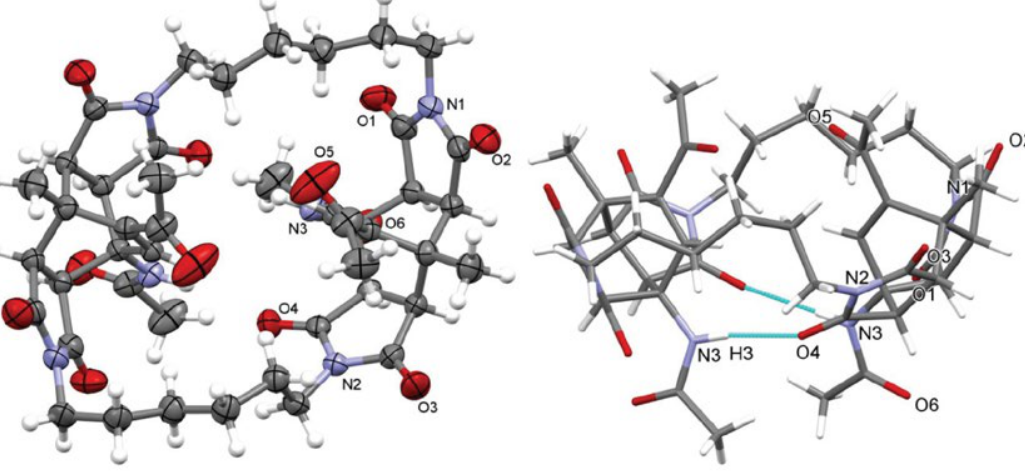
Figure 5. Molecular structure of 3 . Probability ellipsoids are drawn at the 50% level (left). Solvate molecules have been removed for clarity. Intramolec- ular N–H∙∙∙O hydrogen bonding indicated by blue dashed lines (right). Hydrogen atoms not involved in the motif shown have been omitted for clarity.